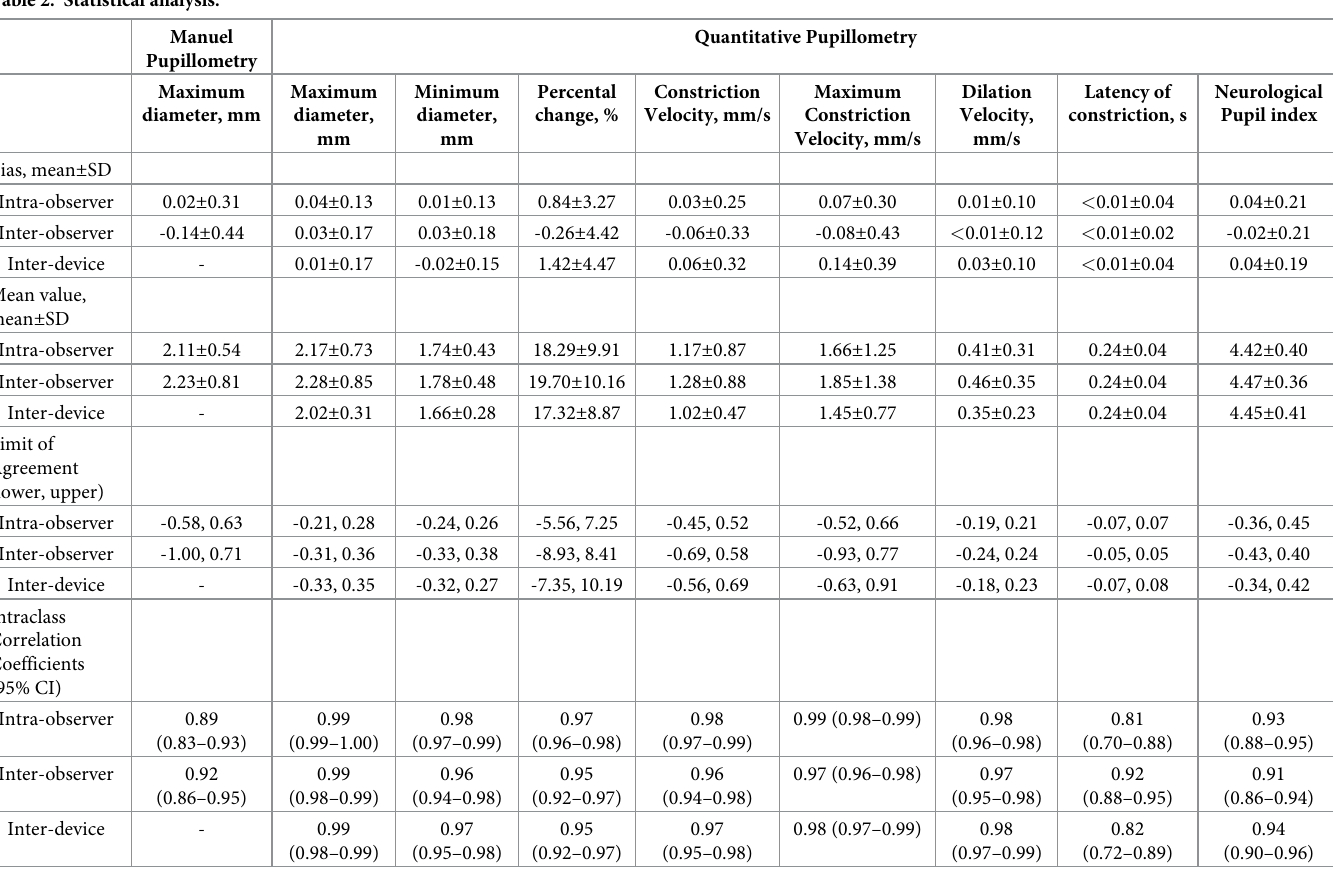
Table 2. Statistical